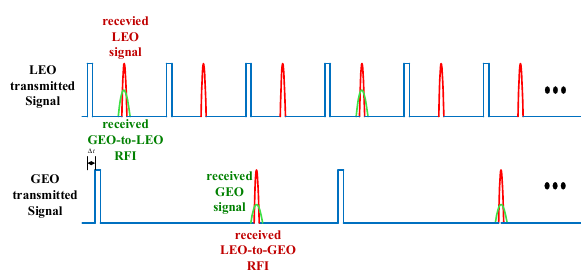
Figure 2. Time series of GEO SARs and LEO SARs.